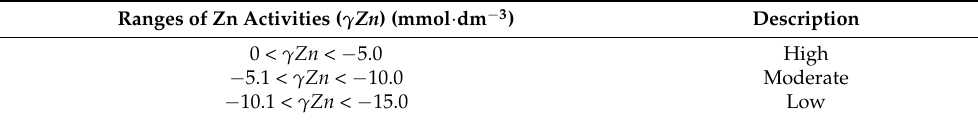
Table 10. Ranges and description used for evaluating zinc activities of the current study.